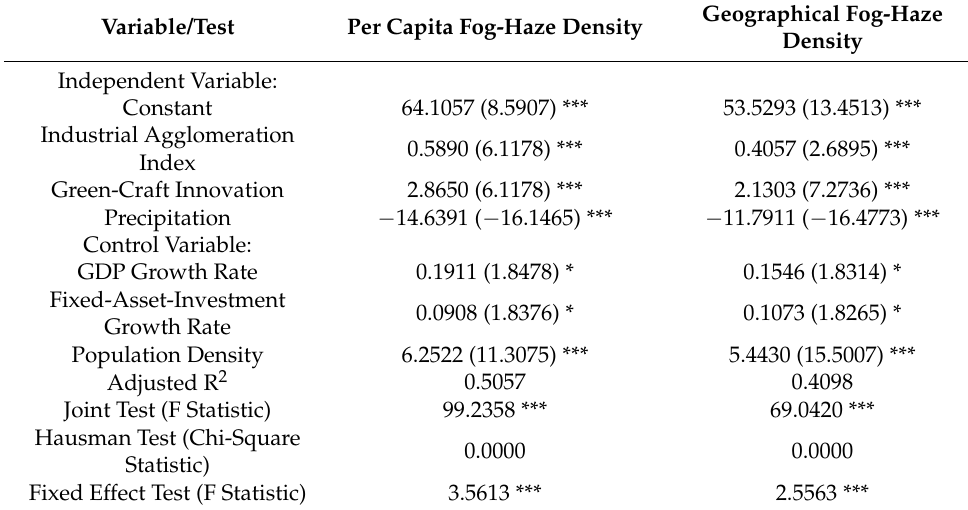
Table 6. Panel regression calculation results.